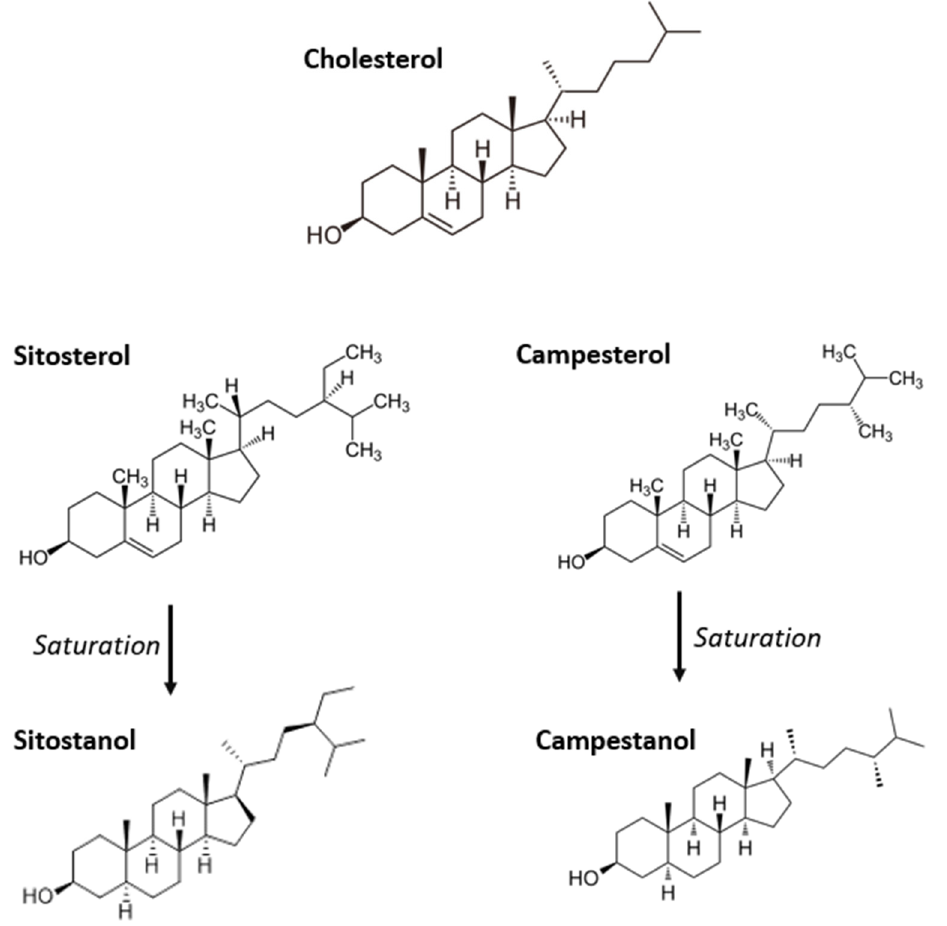
Figure 6. Chemical structure of plant sterols and stanols.